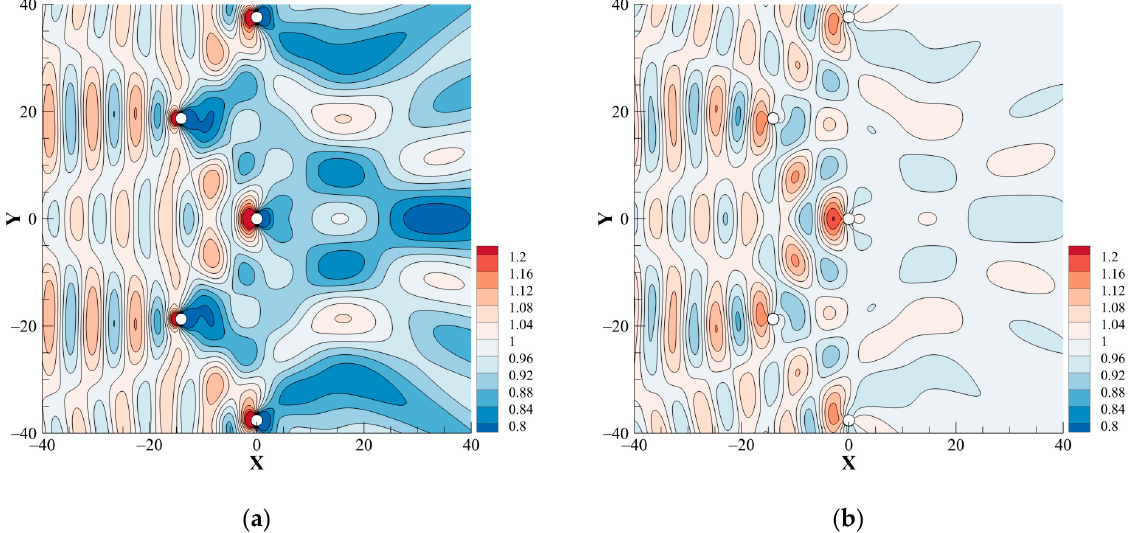
Figure 12. Dimensionless wave amplitude responses of an array composed of five WECs: ( a ) each WEC moves and extracts power in five degrees of freedom; ( b ) each WEC moves and extracts power in heave mode